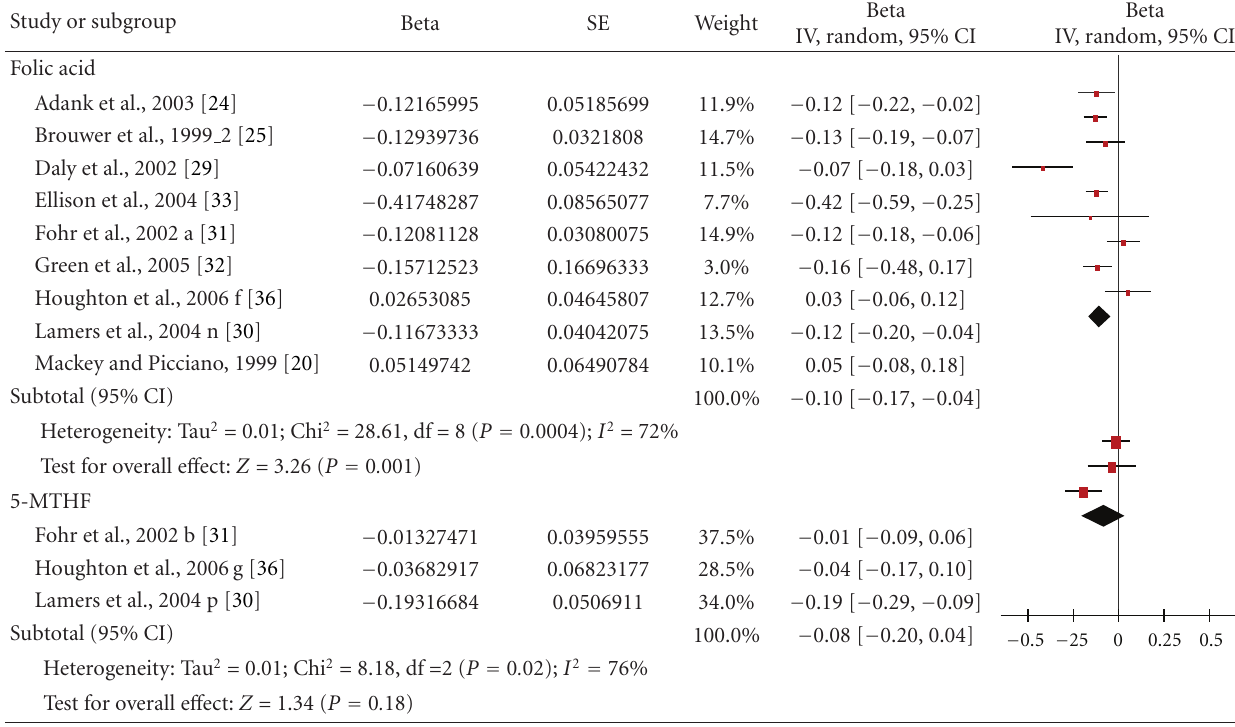
Table 6: Forest plot of the e ff ects of total folate supply (i.e., supplement plus dietary folate), with the supplement provided in form of folic acid and [6S]-5-methyltetrahydrofolate (5-MTHF) on plasma homocysteine (tHcy) folate in childbearing age, pregnant and lactating